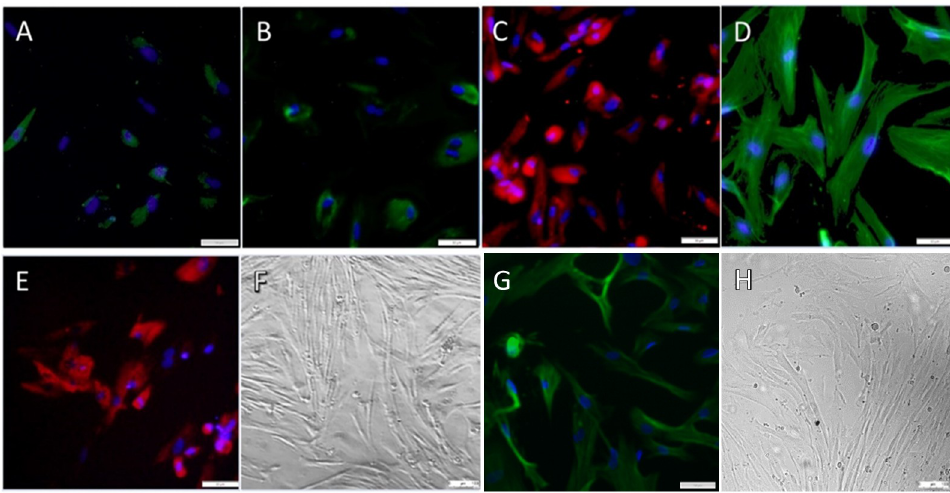
Fig 7. Immunofluorescence analysis of isolated fibroblasts and K9UtMyo1, (A) fibroblasts collagen I (green), (B) fibroblasts collagen III (green), (C) fibroblasts collagen VI (red), (D) fibroblasts vimetin (green), (E) fibroblasts fibronectin (red) and (G) K9UtMyo1 SMA (green) (A-E and G) counterstained cell nuclei (DAPI, blue); (F) morphology of primary cell culture of canine oral mucosa fibroblasts (H) morphology of K9UtMyo1 by light microscopy (at a magnification of 100x).